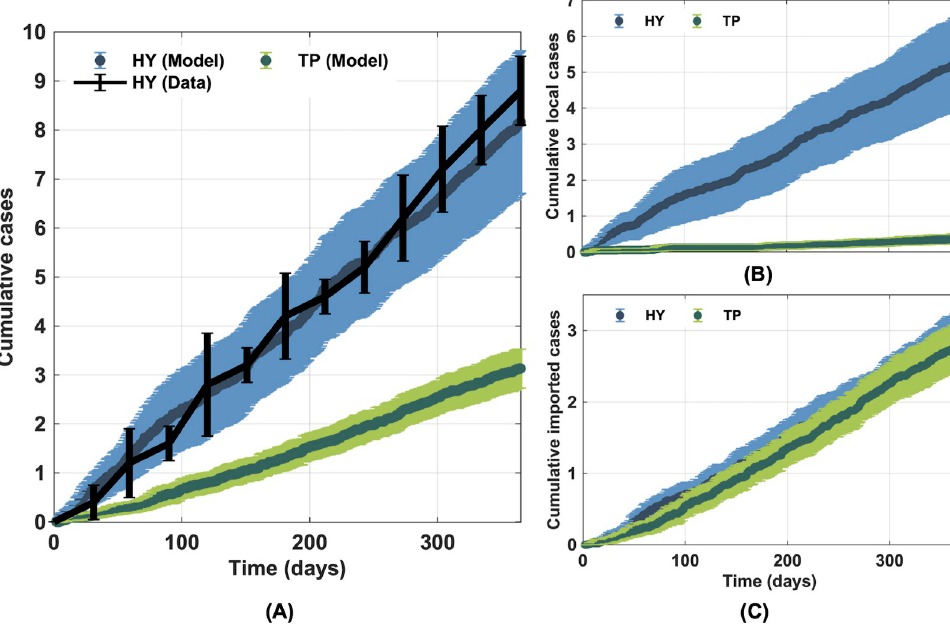
Fig 4. Effect of the geographical distribution of buildings and roads on the rabies transmission dynamics. (A) Comparison of the cumulative number of locally transmitted rabid dogs obtained from the simulations cases simulated in both Hatyai and Tepha and the five-year averaged reported data from Hatyai (years 2016–2020). (B) The number of cumulative locally transmitted cases, and (C) the number of cumulative imported cases in Hatyai (HY) and Tepha (TP).